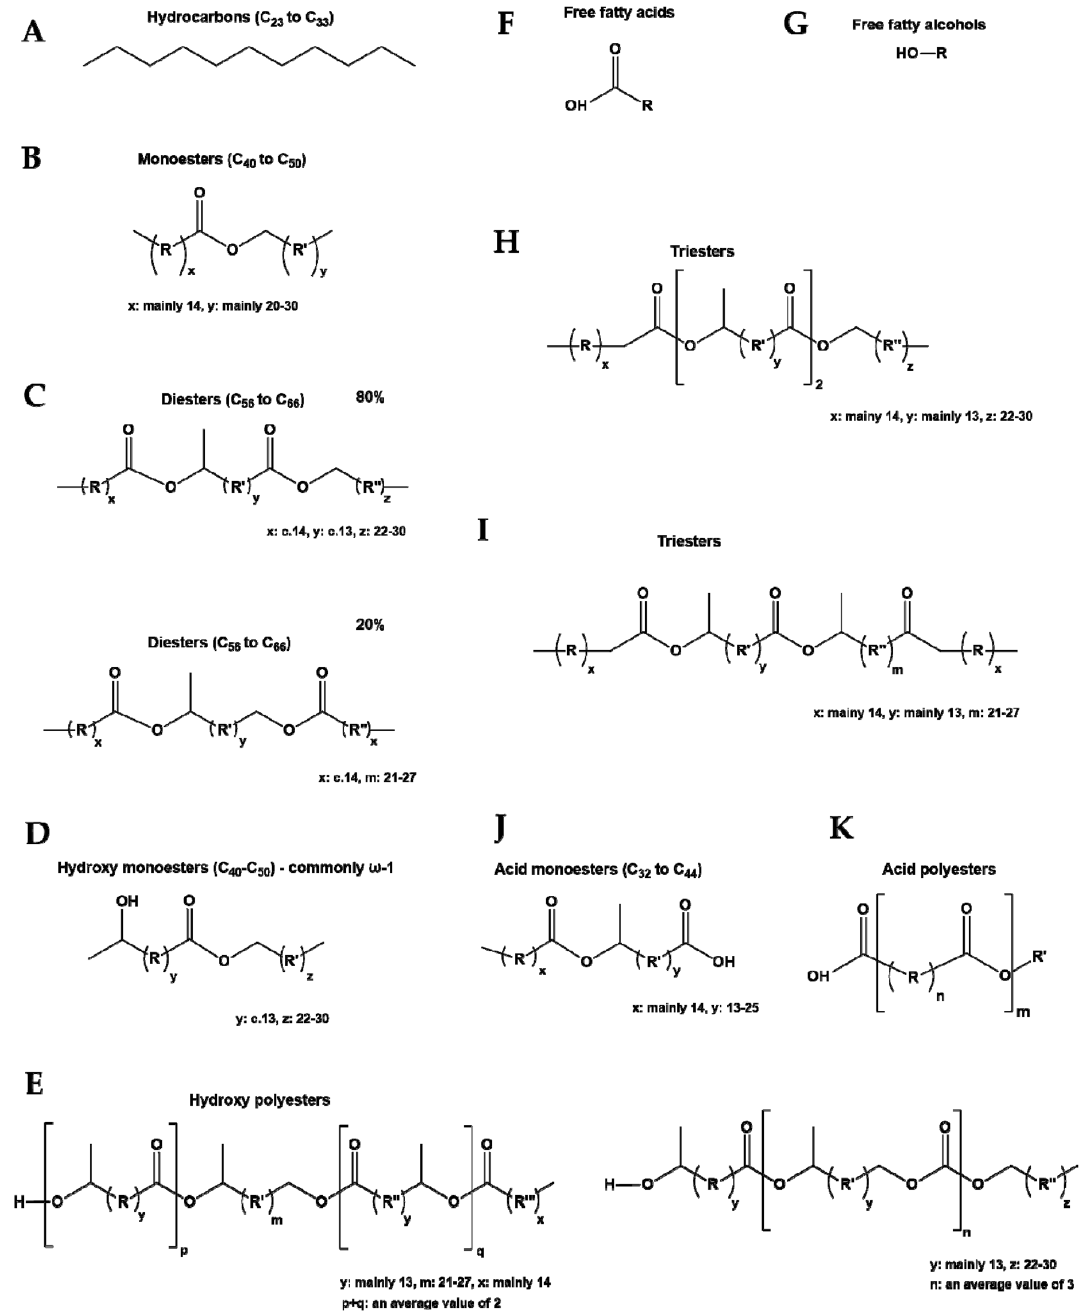
Figure 2. Structural formulae of individual components of